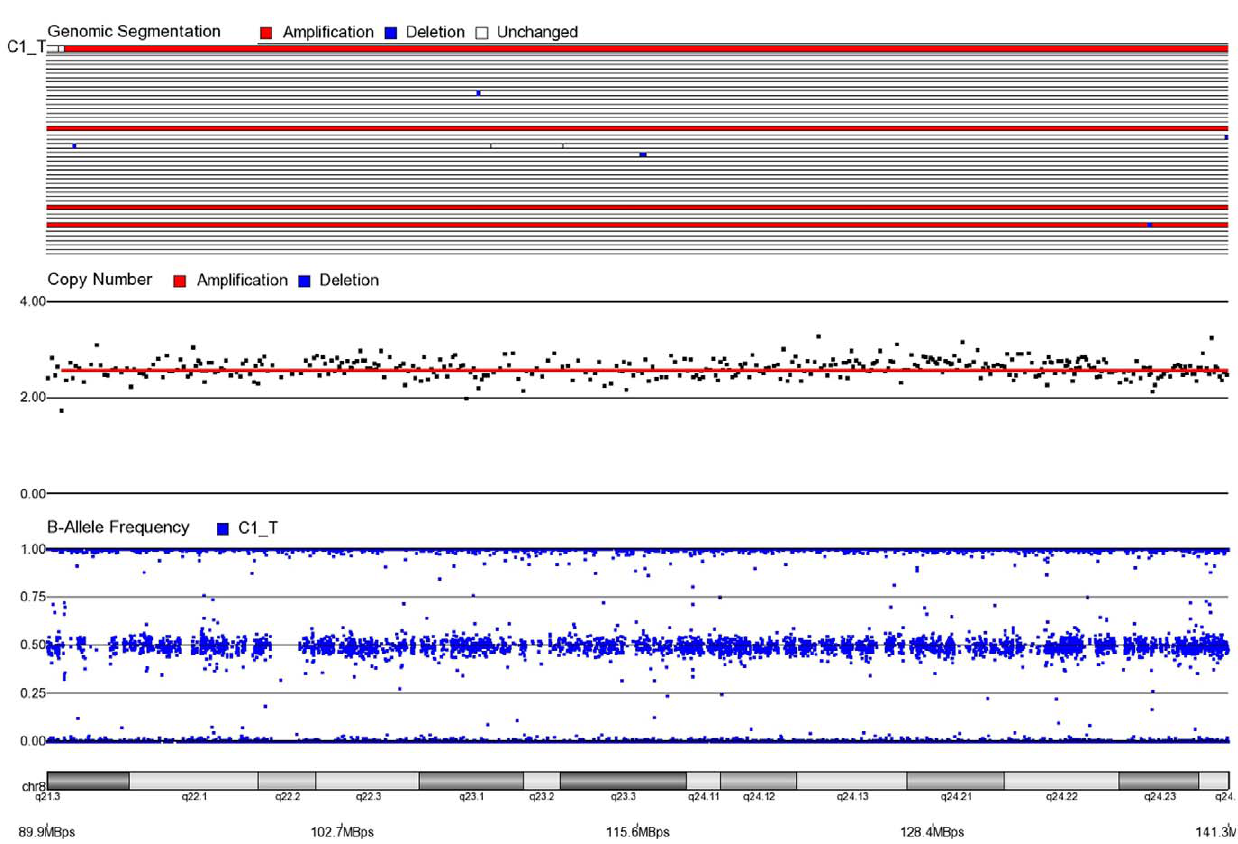
Figure 3. Mosaic biallelic amplification in chromosome 8q for CRC tissue sample C1_T. BAF=0.5 and CN=2.6. Approximately 30% of cells have biallelic amplification